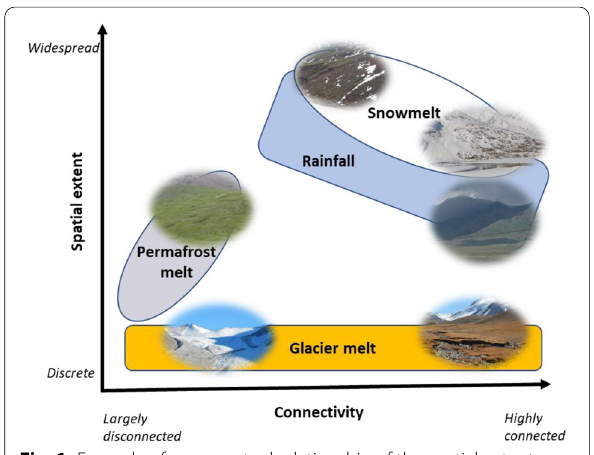
Fig. 1 Example of a conceptual relationship of the spatial extent of dominant water sources and their respective connectivity to channels in high elevation mountains of Central Asia. Such issues need to be considered in hydrological